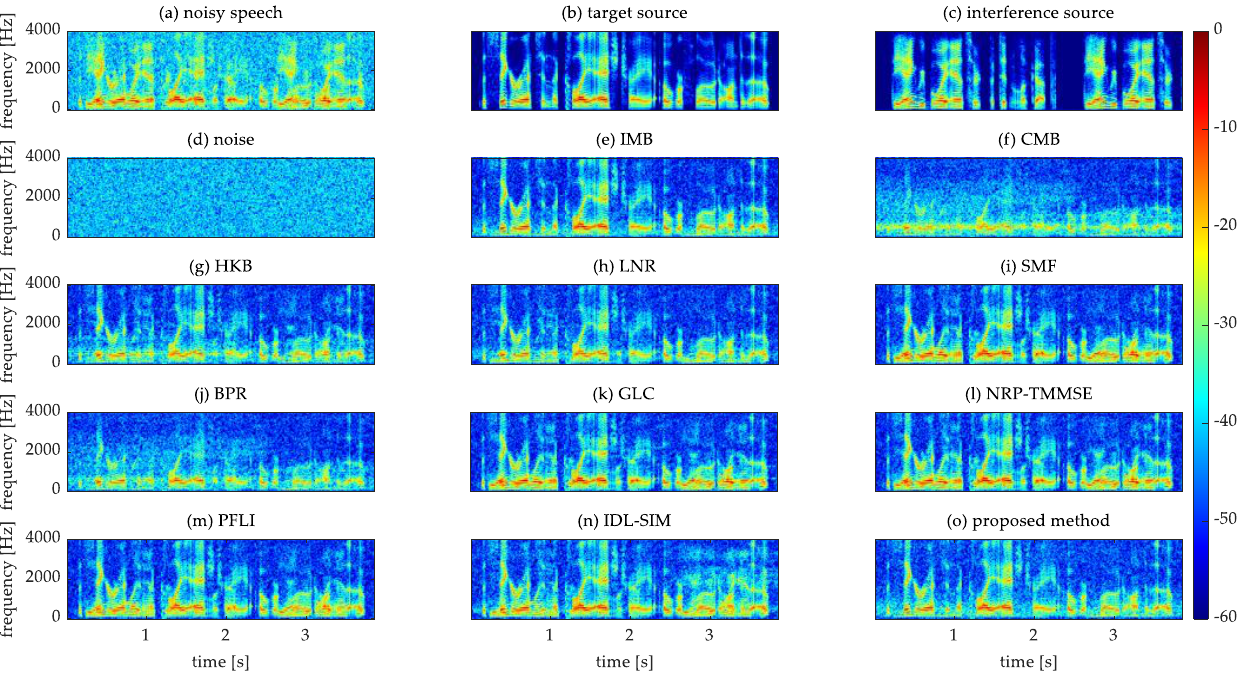
Figure 2. A comparison of spectrograms. The number of snapshots was 100 and the SNR was 10 dB.